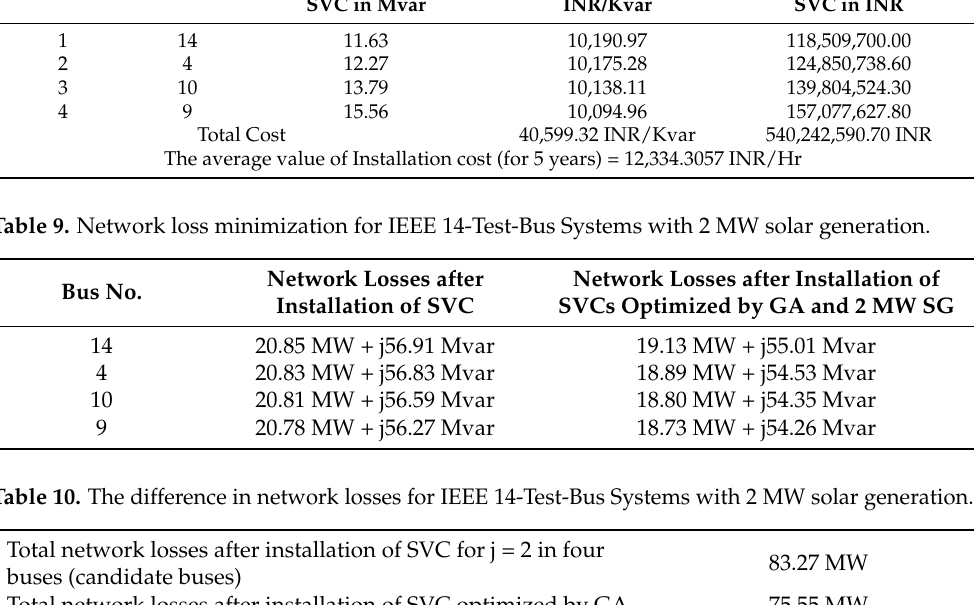
Table 8. Optimal Size of SVCs (determined by GA) for IEEE 14-test-bus system with 2 MW solar generation. SVC No. Bus No.